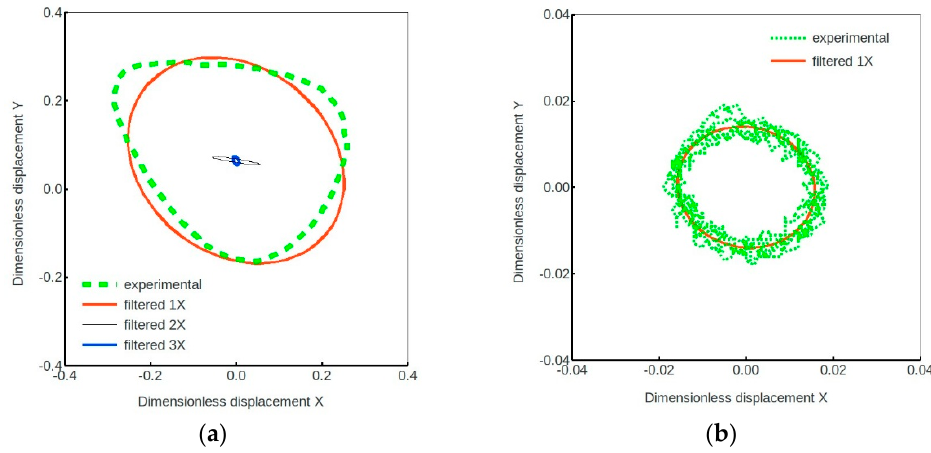
Figure 8. Fast Fourier Transform (FFT) of the X displacement L1-36% ( a ) and L2-3% ( b ) cases.